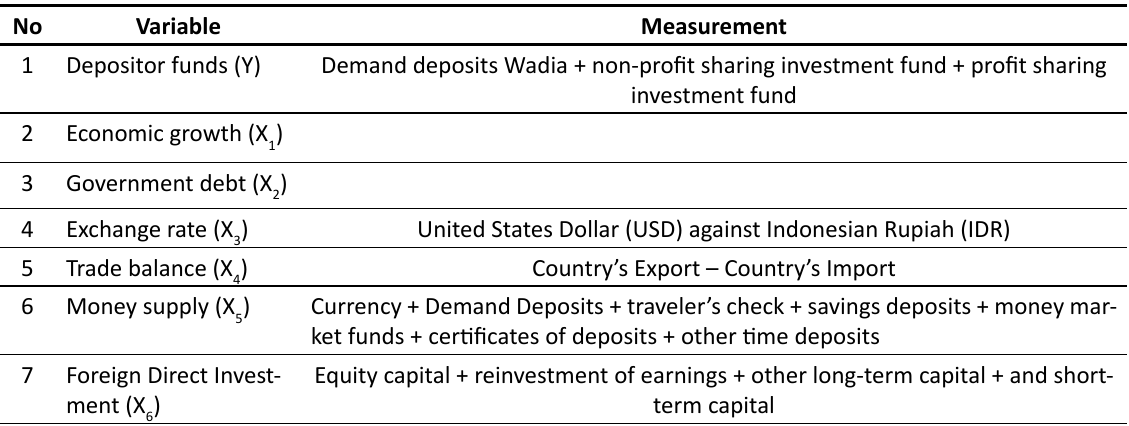
Table 1: Measurement